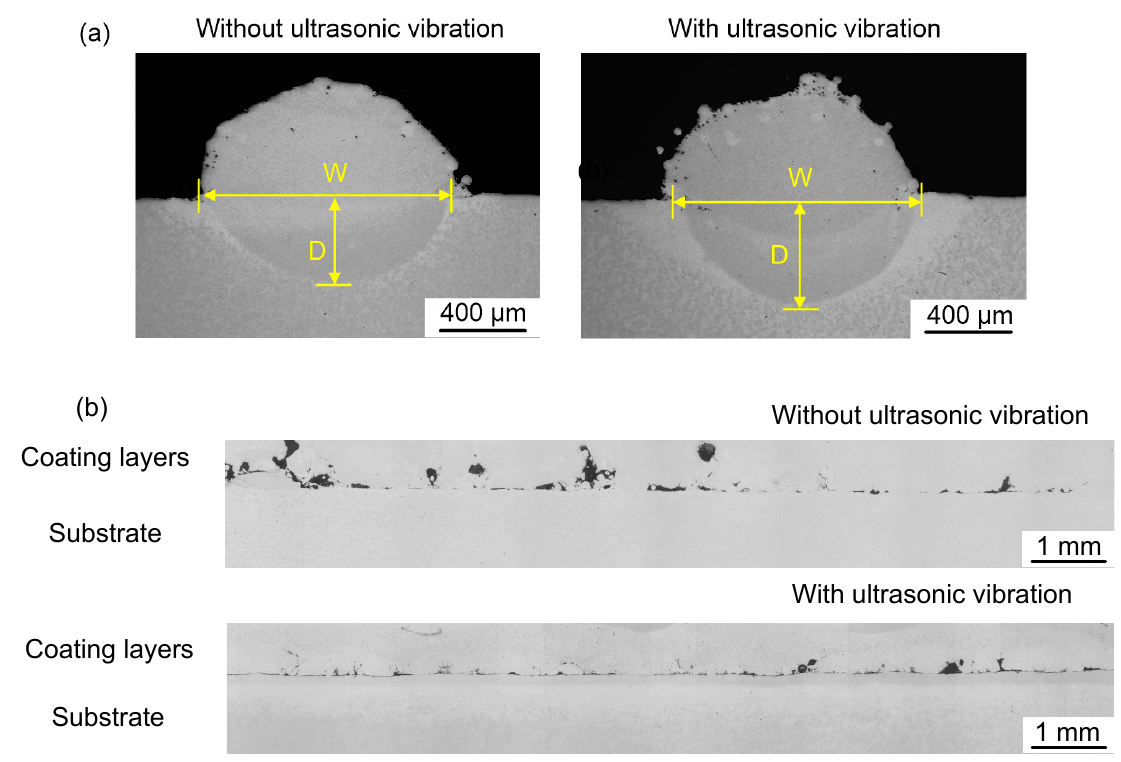
Figure 6. The effects of ultrasonic vibration on bonding quality: ( a ) the molten pool of the TiC-TMC coatings; ( b ) the bonding interface of the TiC-TMC coatings.